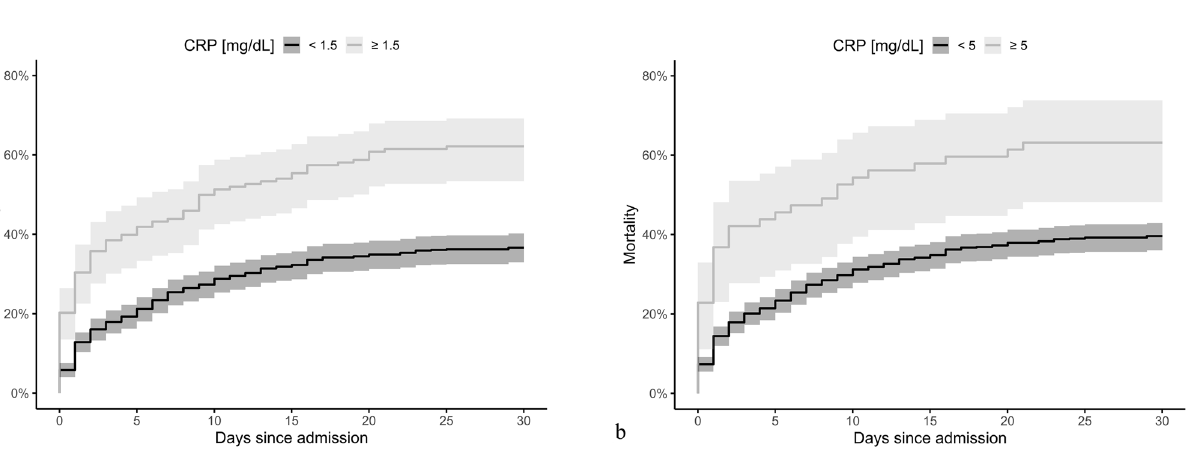
Figure 2. Kaplan–Meier plot of mortality to day 30 among ED patients presenting with OHCA according to ( a ) the CRP cut-off level of 1.5 mg/dL and ( b ) the CRP cut-off level of 5 mg/dL. Shaded areas indicate a 95% confidence interval. CRP C-reactive protein, ED emergency department, OHCA out-of-hospital cardiac